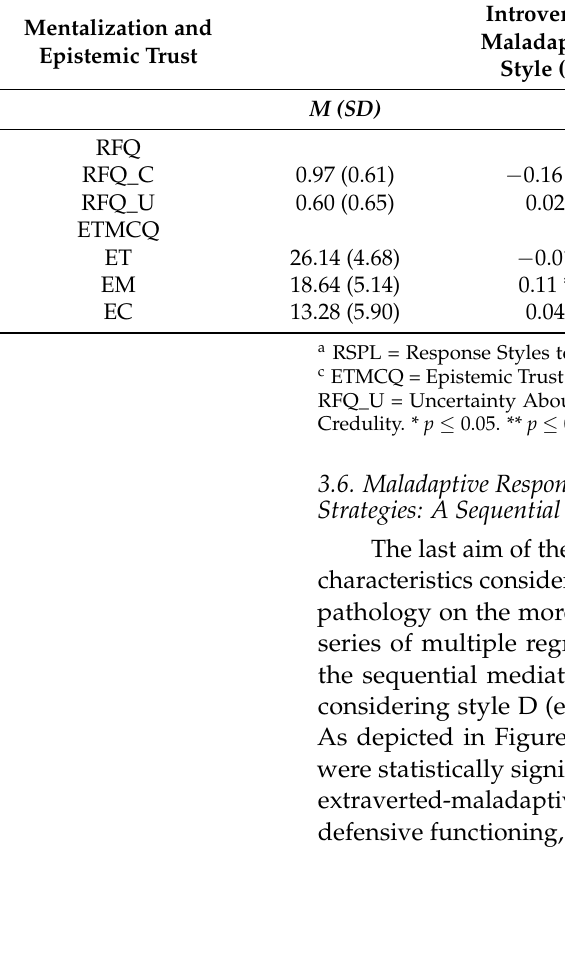
Table 4. Bivariate Correlations Between Response Styles to the COVID-19 Pandemic and Lockdown(s) Assessed Using the RSPL a , Mentalization Assessed Using the RFQ b , and Epistemic Trust, Mistrust, and Credulity Assessed Using the ETMCQ c (N = 367).